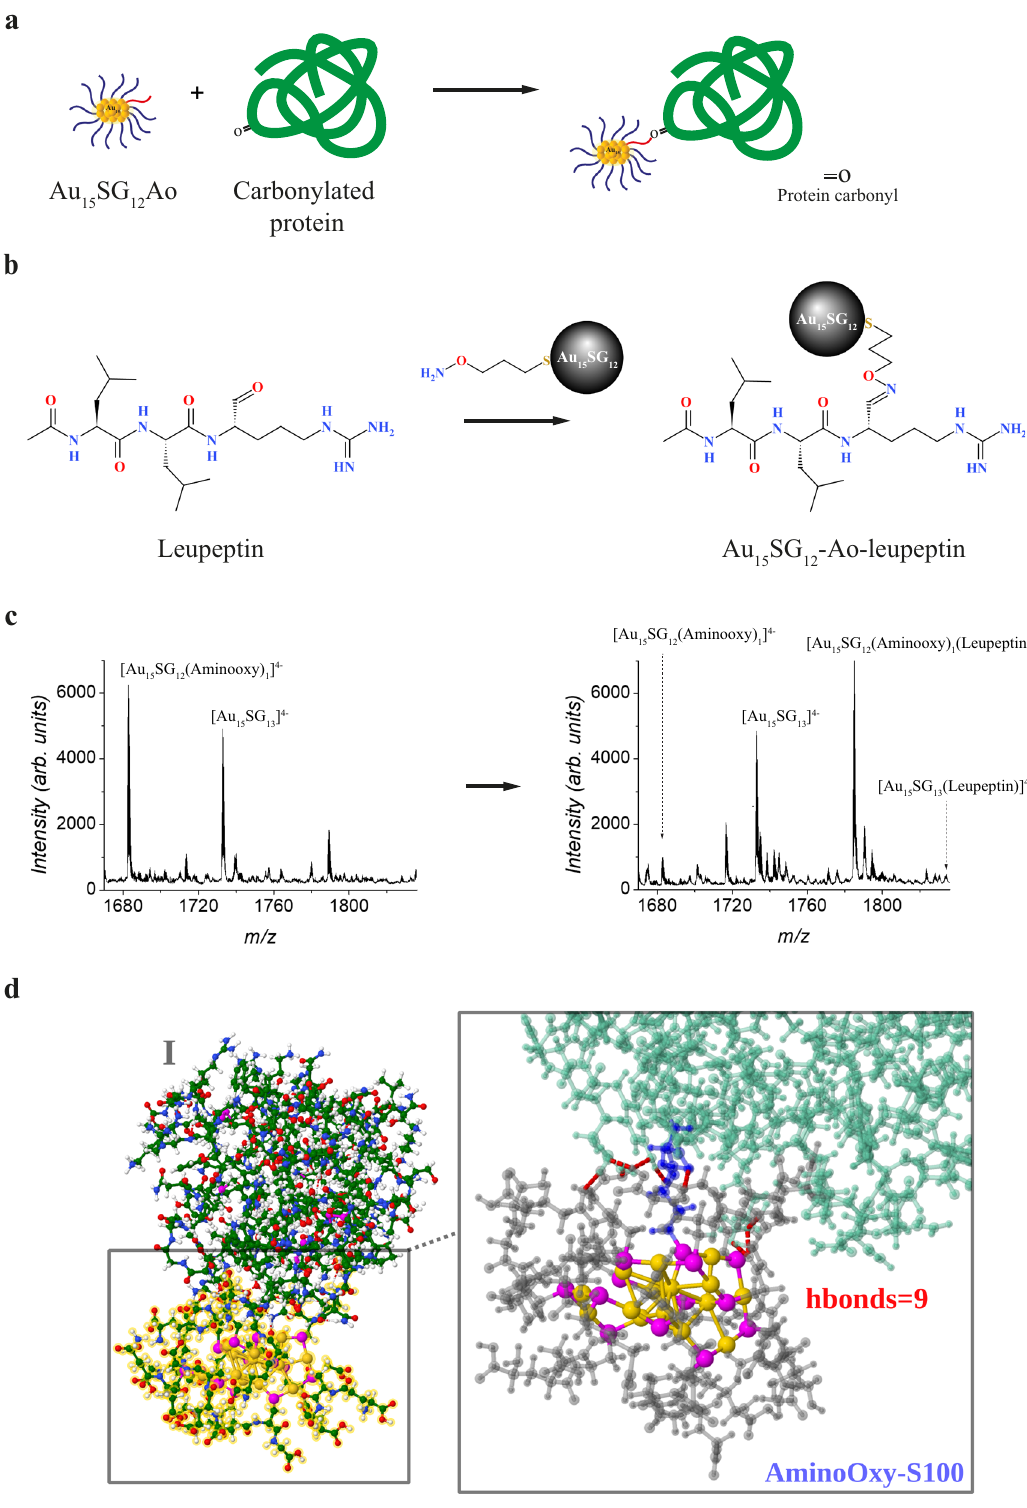
Fig. 2 Au 15 SG 12 -Ao binds to protein carbonyls. a Schematic illustration of the functionalized gold NCs (Au 15 SG 12 -Ao) binding to a carbonylated protein. b Illustration of the reaction of the Ao group of 3-(Aminooxy)-1-propanethiol forming an oxime linkage with the aldehyde of leupeptin. c ESI-MS spectrum following the formation of the stable oxime linkages: a new peak corresponding to Au 15 SG 12 -Ao-leupeptin is observed. d The QM/MM structures obtained by using two-layer ONIOM illustrating the interaction of liganded AuNC with lysozyme. Interface between liganded NCs Au 15 SG 12 -Ao and the protein is enlarged ( right ) illustrating Ao-serine oxime bond and hydrogen bonding network. (SG-gray, Au-gold, S-magenta, lysozyme-green, Ao-Serine oxime bond- blue, H-bonds-dotted in